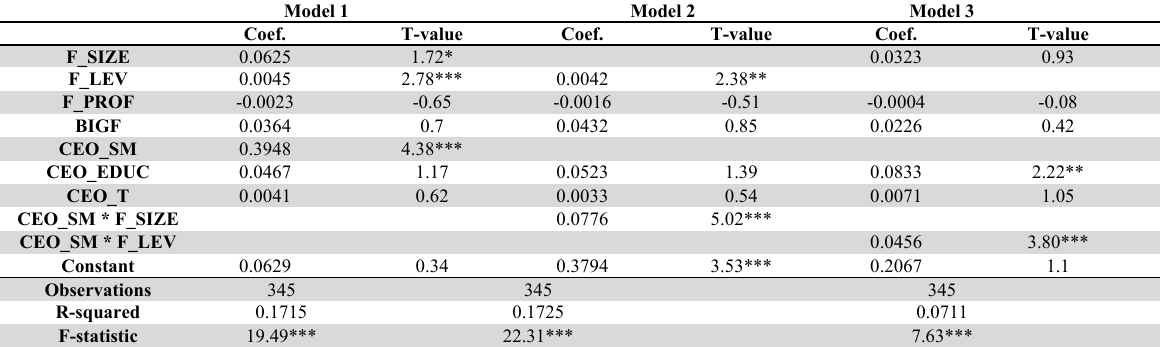
The results of multiple